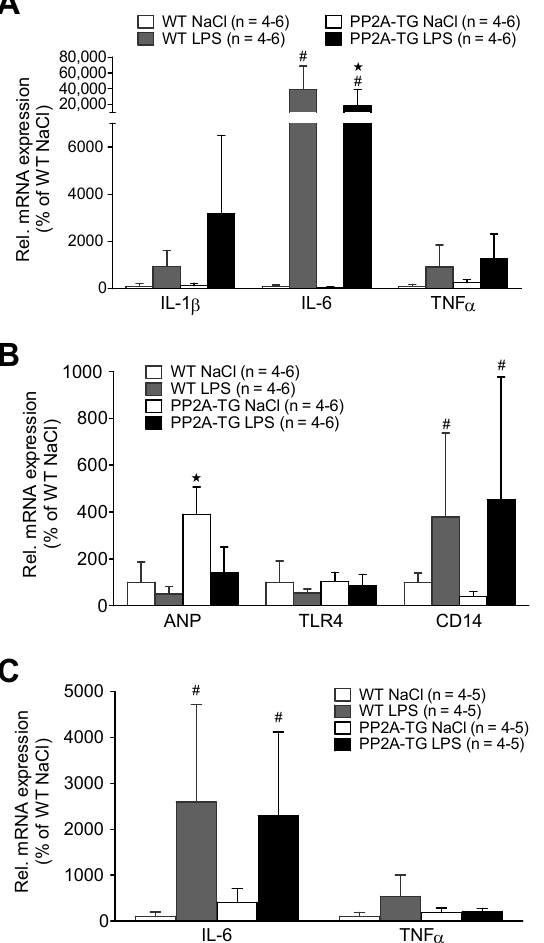
Figure 5. LPS-mediated gene expression. Cardiac gene expression analyzed by qPCR of wild type (WT) and PP2A overexpressing (PP2A-TG) mouse hearts after intraperitoneal application of LPS or NaCl solution as control (Ctr) after 7 h. Ordinates display relative mRNA expression in percentage of control, that is, WT hearts from mice treated with isotonic sodium chloride solutions alone (solvent control). ( A ) displays the mRNA for interleukin 1 beta (IL-1 β ), for interleukin 6 (IL-6) and for tumor necrosis factor alpha (TNF α ). ( B ) displays the mRNA for atrial natriuretic peptide (ANP), for toll